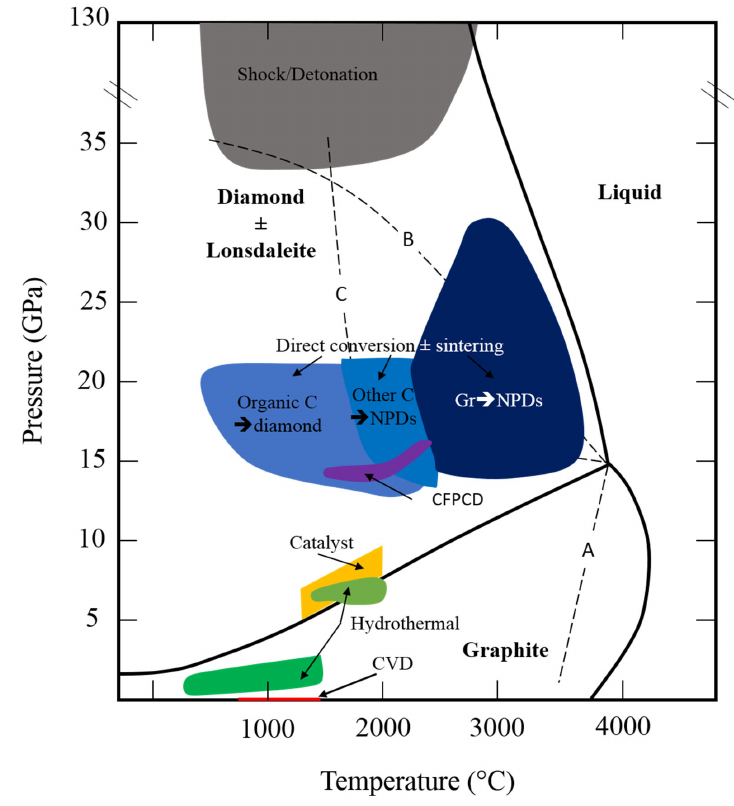
Figure 5. P–T phase diagram of carbon are adapted from [57]. Solid lines are the limits between stability fields. A and B dashed represent the limits between metastability fields, respectively, graphite + metastable diamond and diamond + metastable graphite. C dashed line represents a hypothetical limit between lonsdaleite and diamond stability field. Colored areas show the P–T conditions for the synthesis of diamonds according to the different techniques used.